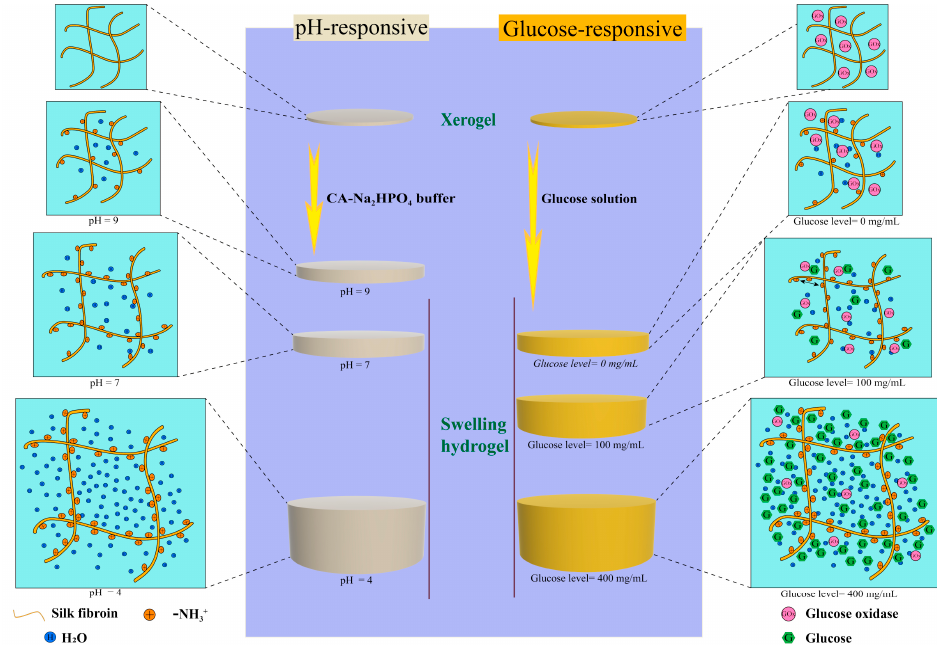
Figure 1. Proposed working principle of the pH-responsive swelling hydrogel ( left ) and glucose-responsive swelling hydrogel ( right ).